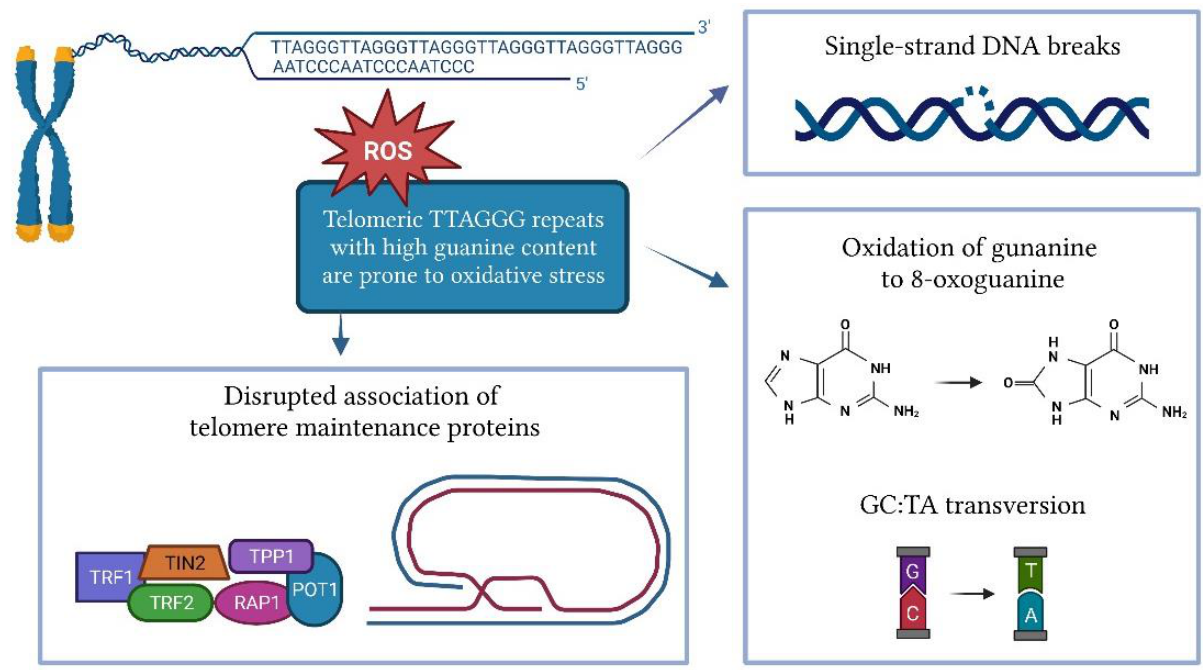
Figure 2. Impact of oxidative stress on telomere length.